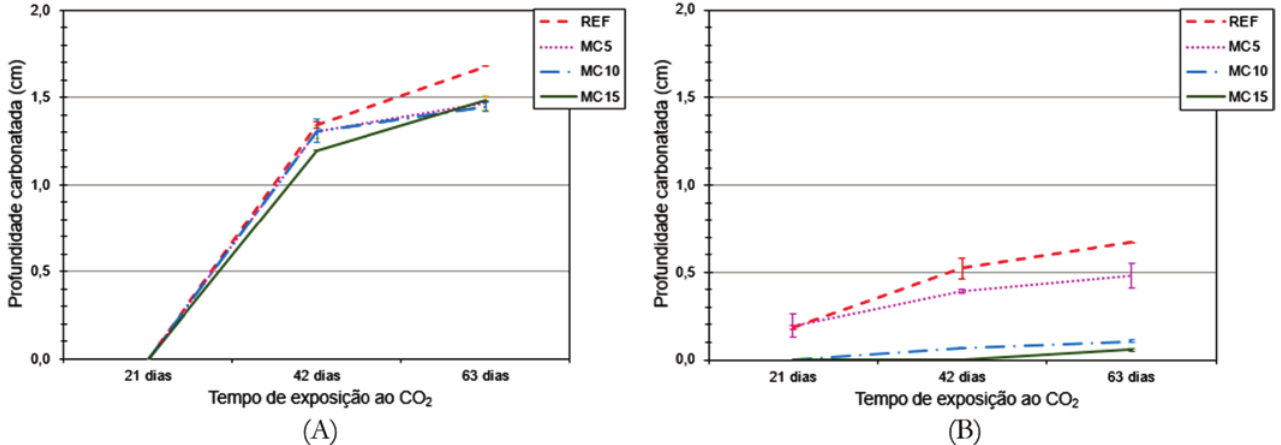
Figura 7 Verificação da região carbonatada de amostras de concreto (A) secas e (B) saturadas em água, após exposição em câmara de